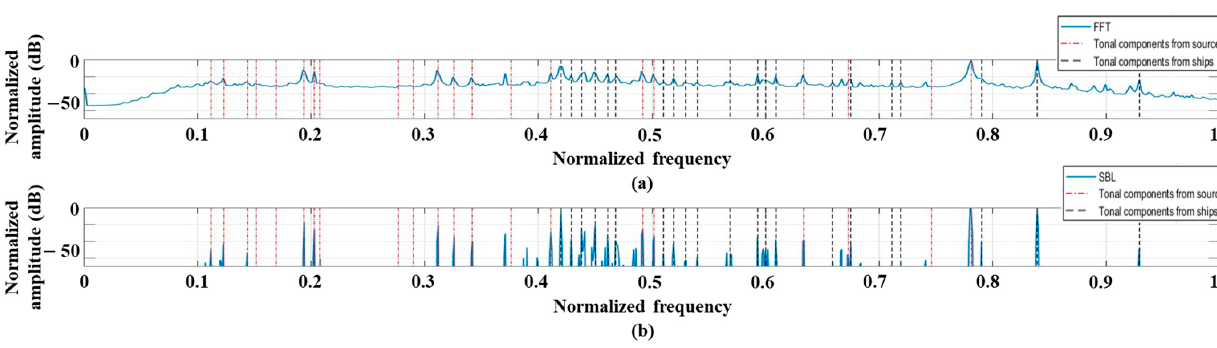
Figure 9. Averaged frequency detection results of Figure 8e,f over time according to ( a ) FFT and ( b ) SBL. Sparse estimations from the SBL reveal the frequency components more clearly.